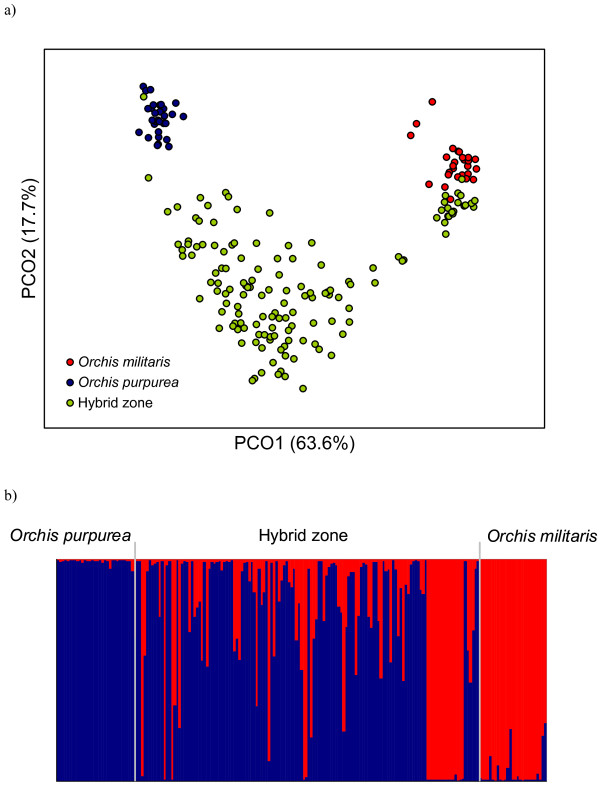
Clustering analysis of AFLP data for a pure Orchis militaris population, pure O. purpurea population and a hybrid population. (a) Principal coordinate (PCO) plot based on individual genetic distance calculated with 113 AFLP markers. The first two axes explain 63.6% and 17.7% of the variation, respectively. (b) Clustering analysis using structure. Individuals are represented by columns, with colours representing the proportion of their genome assigned to the K = 2 inferred clusters in the model-based admixture analysis.